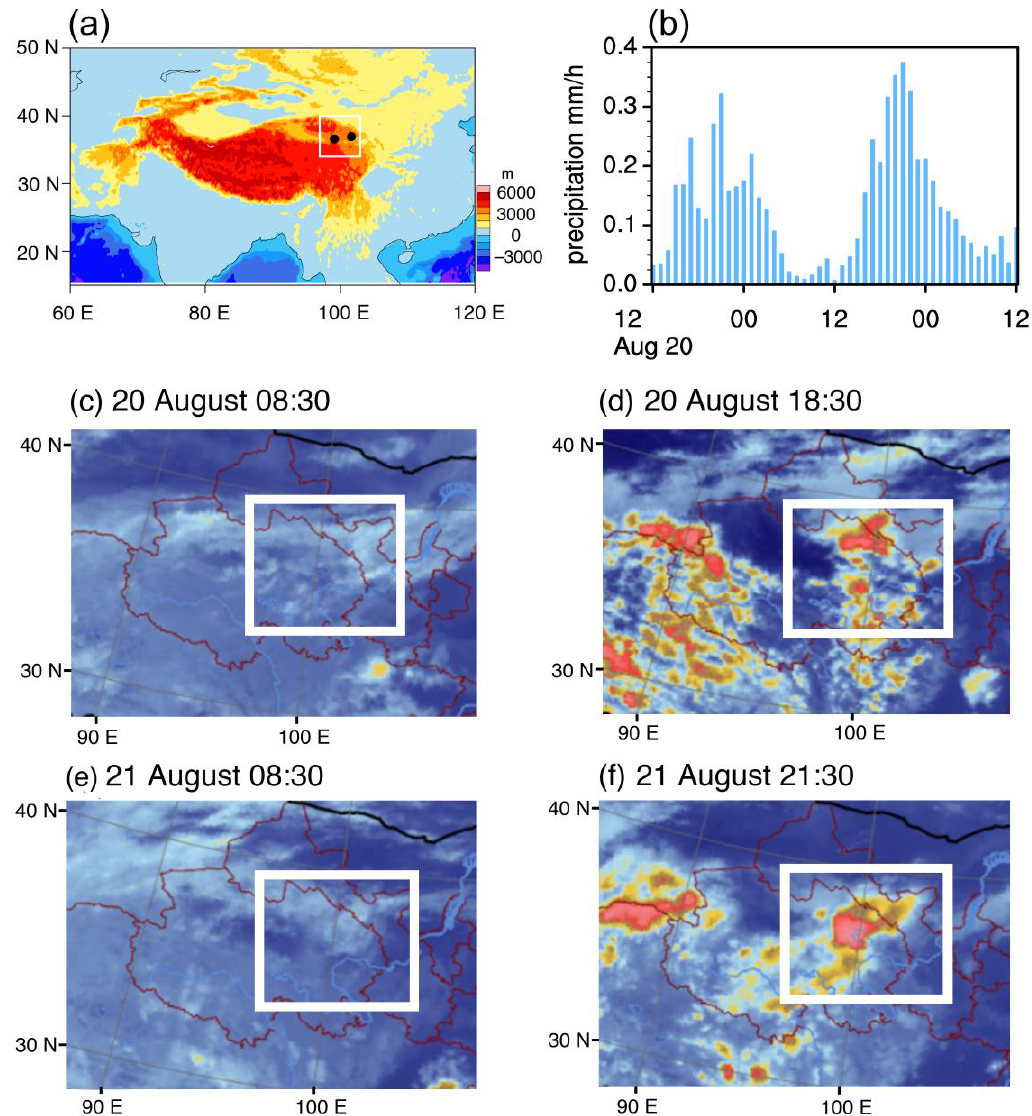
Figure 1. ( a ) Elevation (m) of the Tibetan Plateau above sea level, and ( b ) time series of domain (white box in Figure 1a) averaged precipitation (mm / h) for August 20 and 21 2013. Infrared cloud imagery at ( c ) 08:30 (local time) on 20 August 2013, ( d ) 18:30 on August 20th 2013, ( e ) 08:30 on 21 August 2013, and ( f ) 21:30 on 21 August 2013. The warm colors in ( c ), ( d ), ( e ), and ( f ) indicate convective clouds.